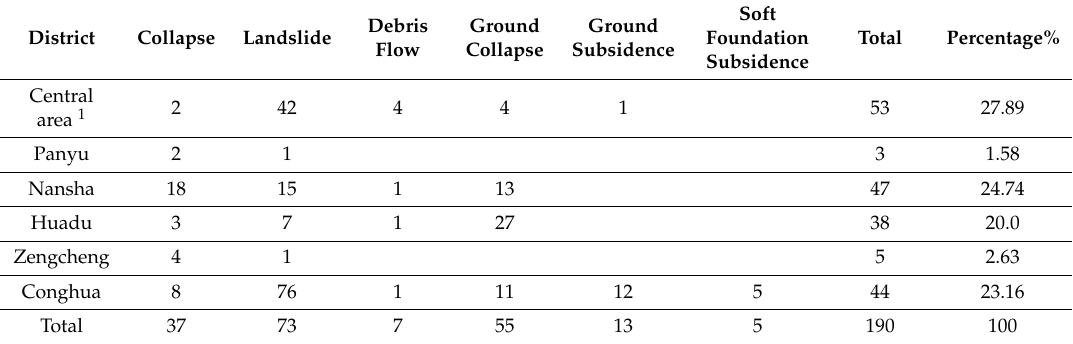
Table 3. Distribution of geological disasters in